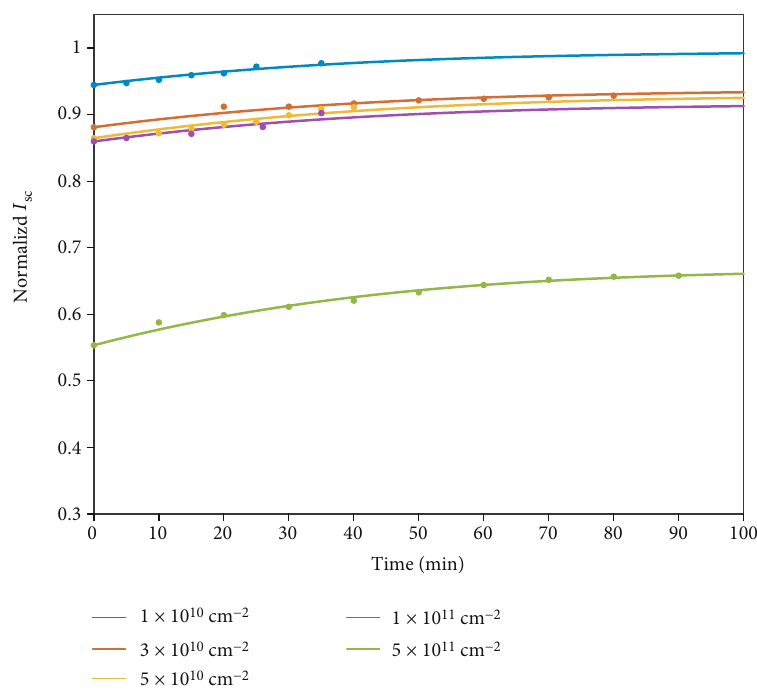
Figure 8: In situ measurement for I